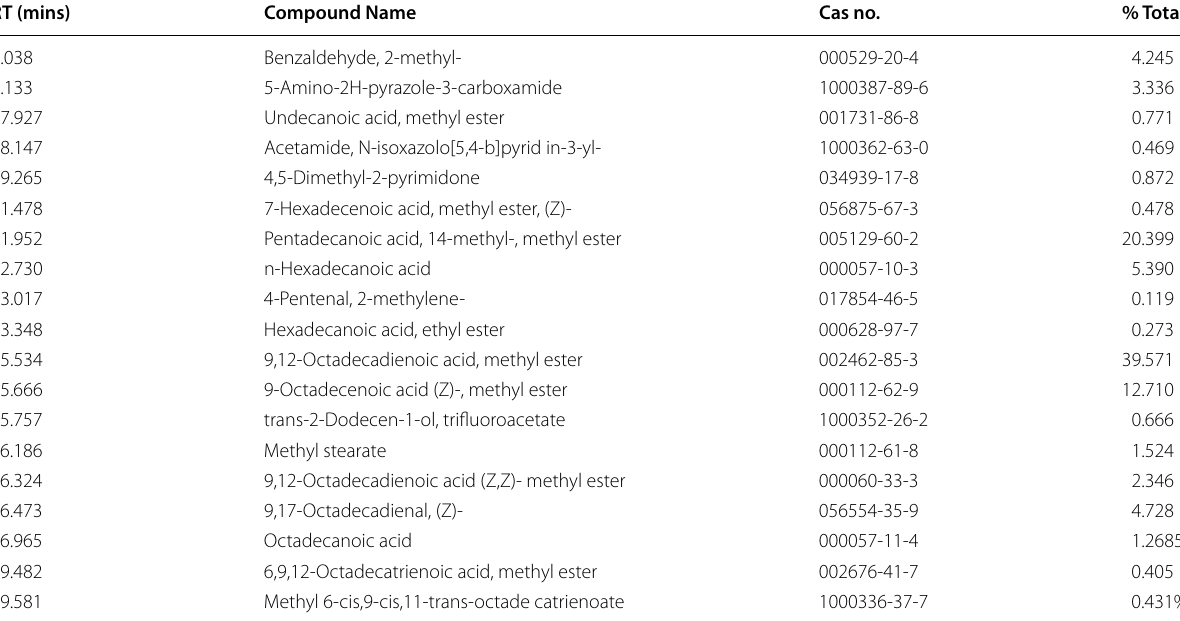
Table 7 Chemical compounds present in cowpea pod